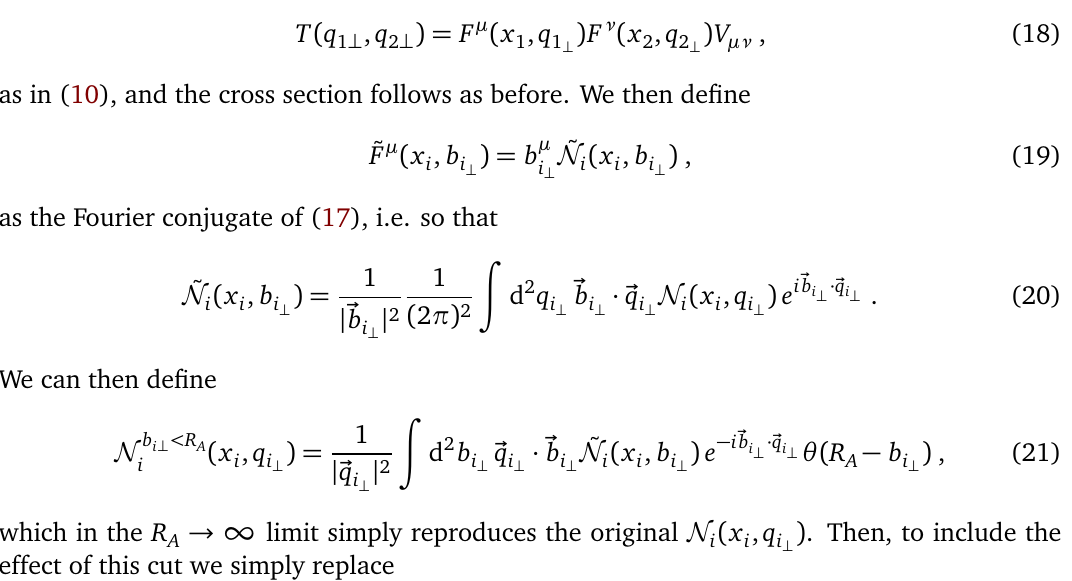
Figure 1: Comparison of q 2 as described in the text. The proton (lead) case is shown in the left (right) plots, and representative values of x = 10 − 3 (10 − 5 ) are taken, corresponding to the production of ∼ 10 GeV system at central rapidity for